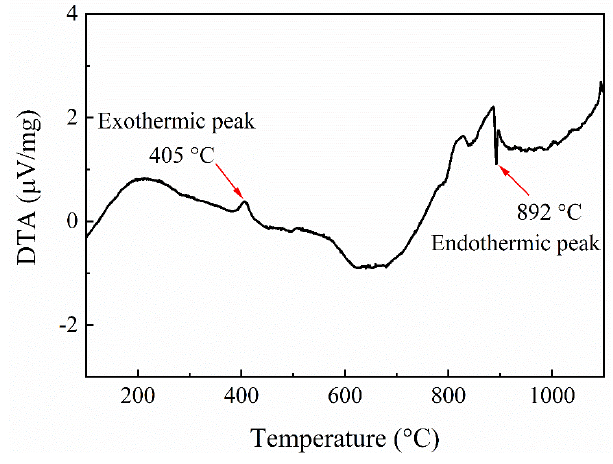
Figure 4. DTA curve of electrodeposited Ni-13.4Cr-11.6P alloy coating.